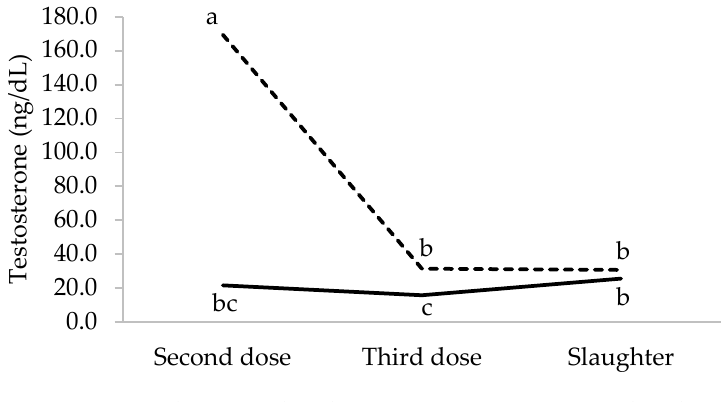
Figure 1. Interaction type of castration × sampling time ( p < 0.0001) on serum testosterone concen- tration ( n = 9 per type of castration at each sampling time). After the data had been transformed, statistical analysis was performed on it. Data are presented as back-transformed least square means. Different letters (a, b or c) are used to indicate values that differ significantly ( p < 0.05).